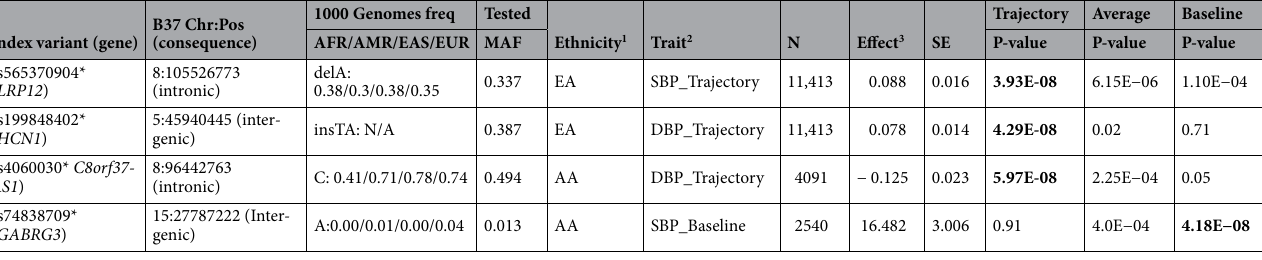
Table 2. Genome-wide statistically significant ( p < 5 × 10–8) and borderline genome-wide statistically significant ( p < 9 × 10–8) associations in the GWAS meta-analysis which had additional evidence of association in independent datasets. *Novel blood pressure associations (250 kb away from known loci). N/A Not Available 1 AA = African American, EA = European-American, TRANS = Transethnic. 2 SBP = Systolic blood pressure, DBP = Diastolic blood pressure. 3 The variant effect corresponds to the outcome that was statistically significant.